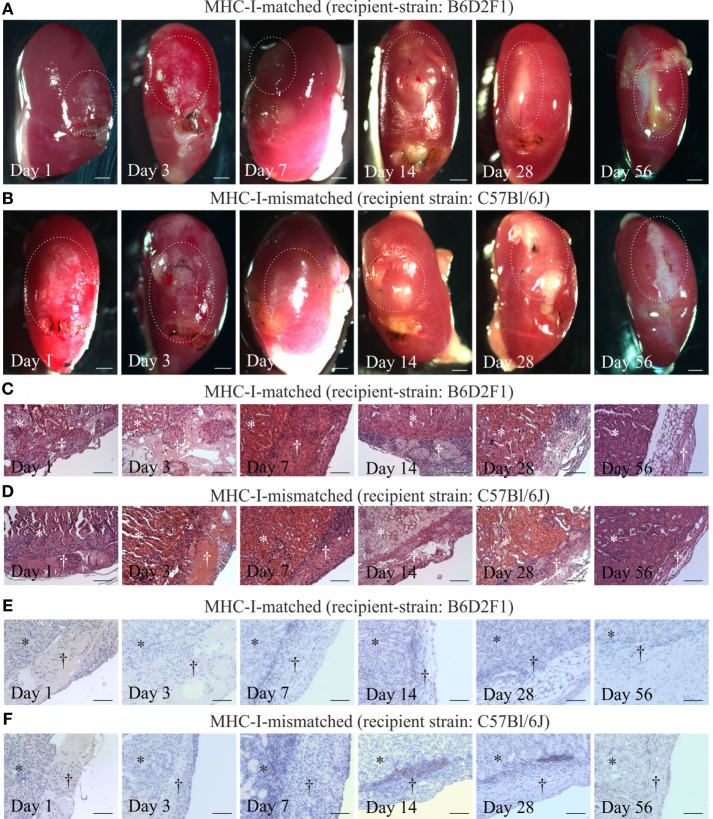
Cardiomyocyte retention and cellular infiltration after implantation of parthenogenetic stem cell-derived cardiac bodies under the kidney capsules of major histocompatibility complex (MHC)-matched or -mismatched mice. Macroscopic images (A,B), hematoxylin & eosin staining (C,D), and immunohistochemistry for CD3 (E,F) 1, 3, 7, 14, 28, and 56 days after grafting of cardiac bodies under the kidney capsules in MHC-matched (A,C,E) or -mismatched (B,D,F) mice. The implantation sites in the macroscopic images are marked by doted lines. In the histological images, the area of the kidney is marked by stars, the area of implantation is marked by crosses (n = 2–5/time point). Scale bars: (A,B): 500 µm; (C–F): 100 µm.